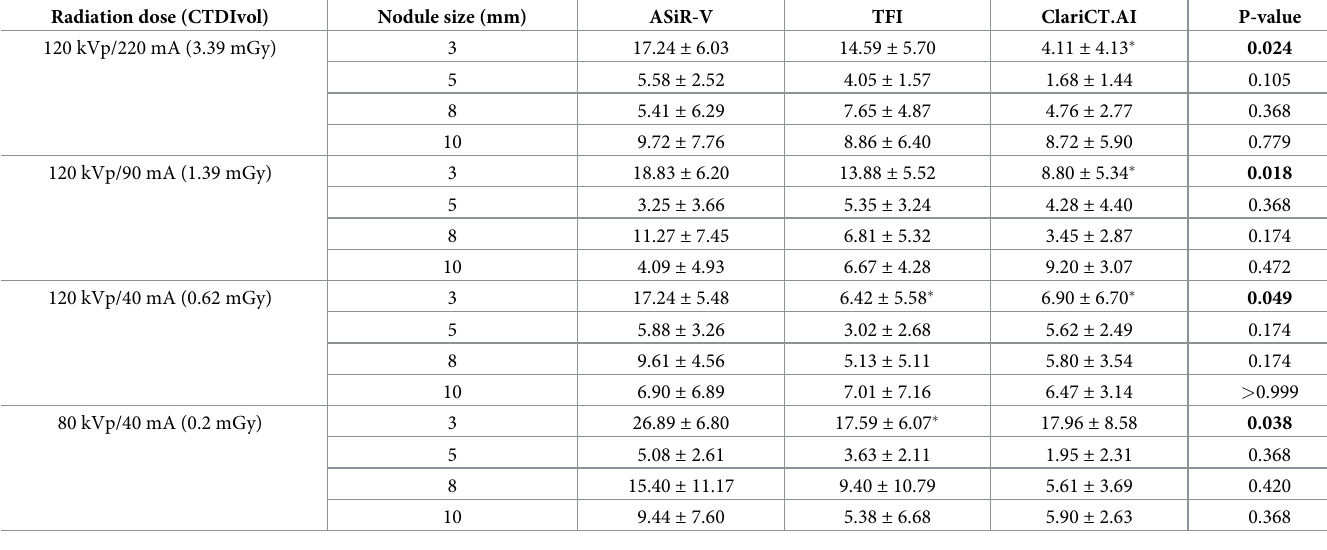
Table 4. Absolute percentage measurement error according to solid nodule size. Radiation dose